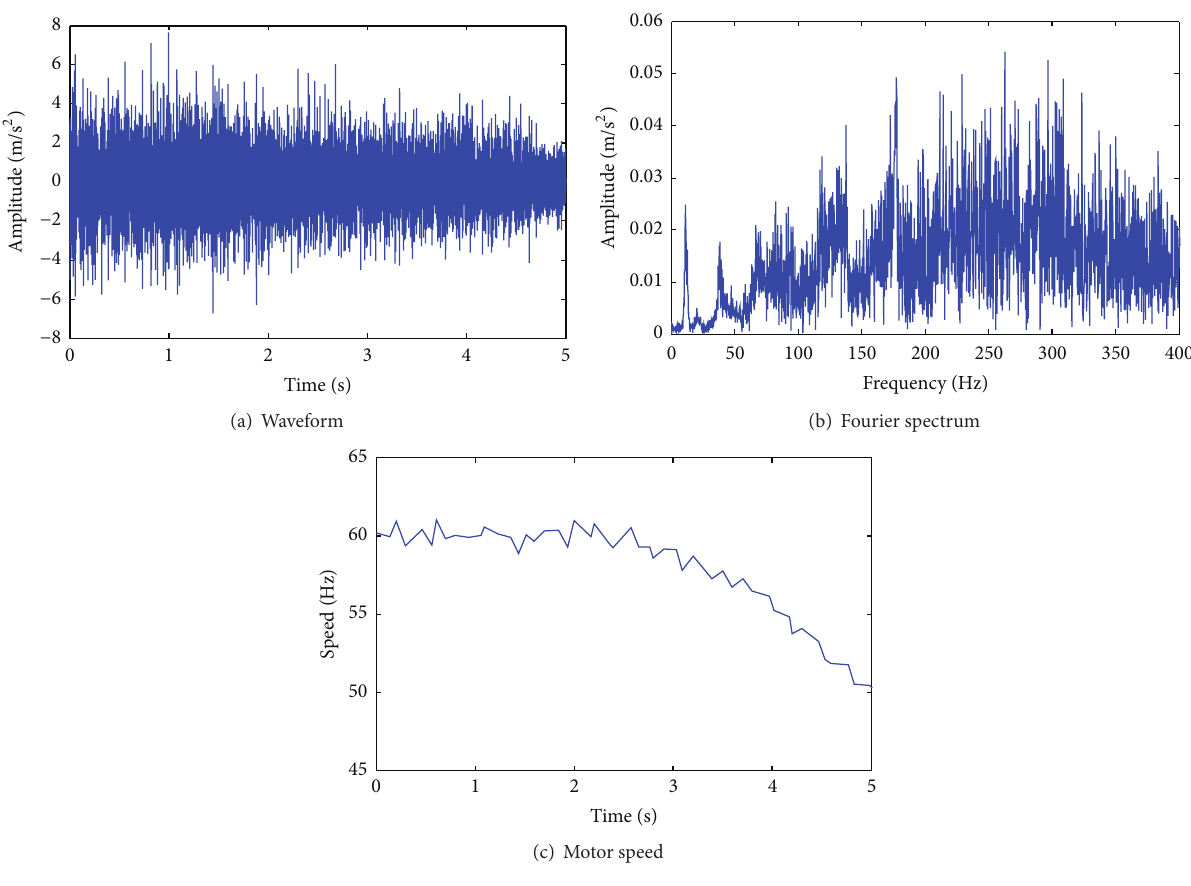
Figure 5: Baseline